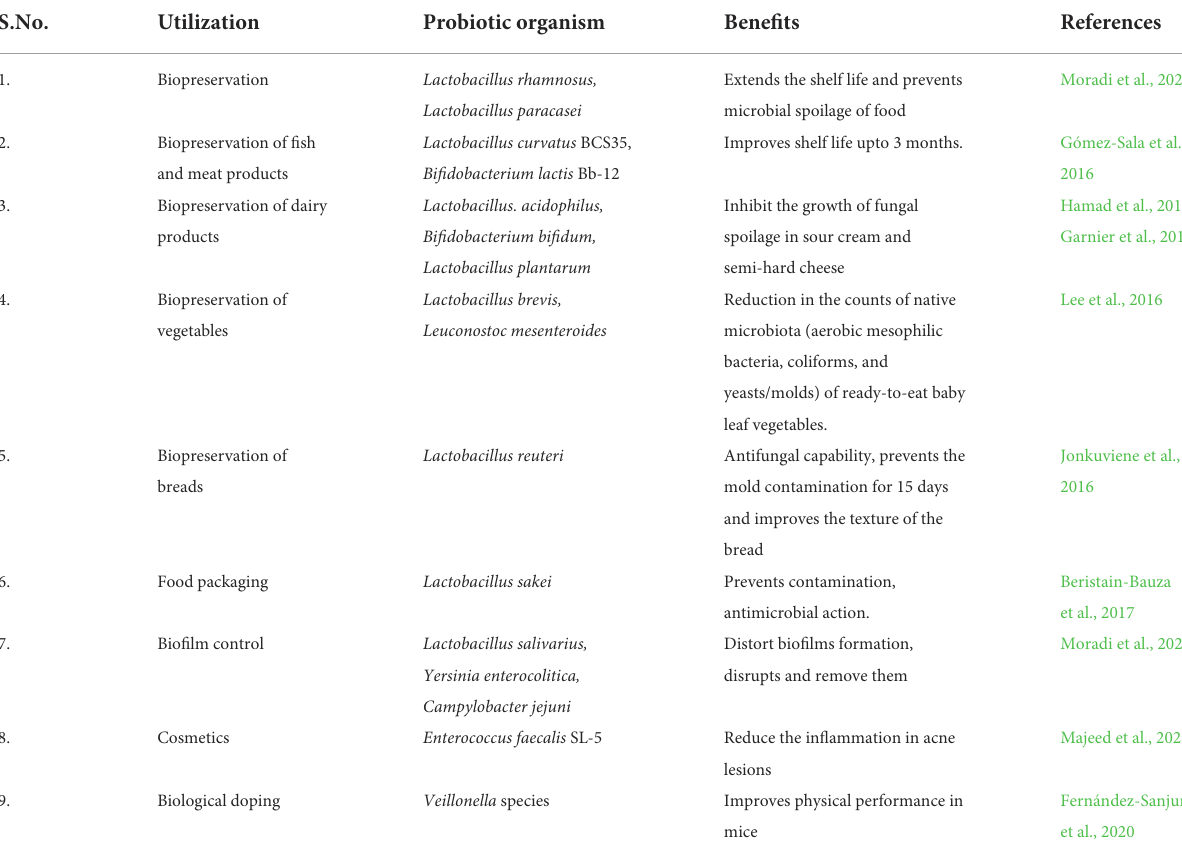
TABLE 2 Non-clinical use of